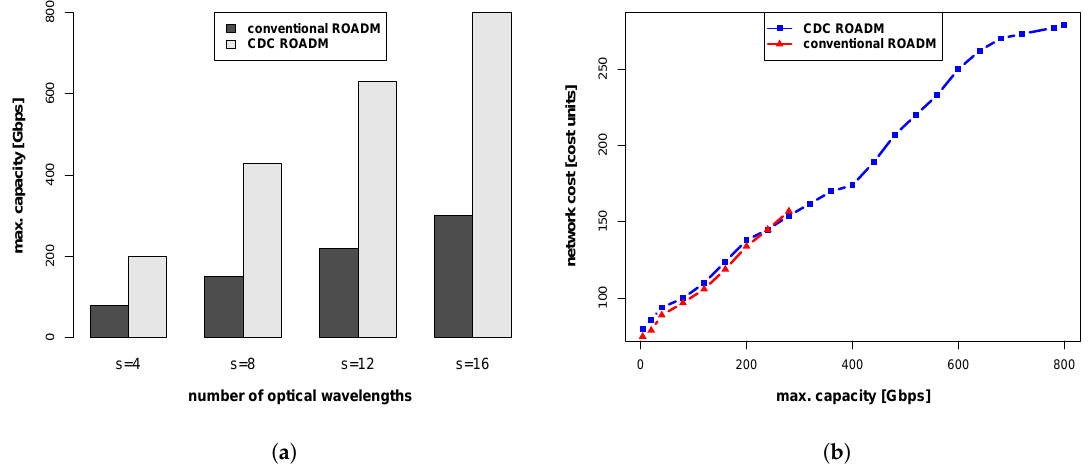
Figure 4. Dependence of maximum capacity of the network on the number of optical wavelength ( a ) and the dependence of network cost on maximum capacity of the network ( b ) for net5 network.